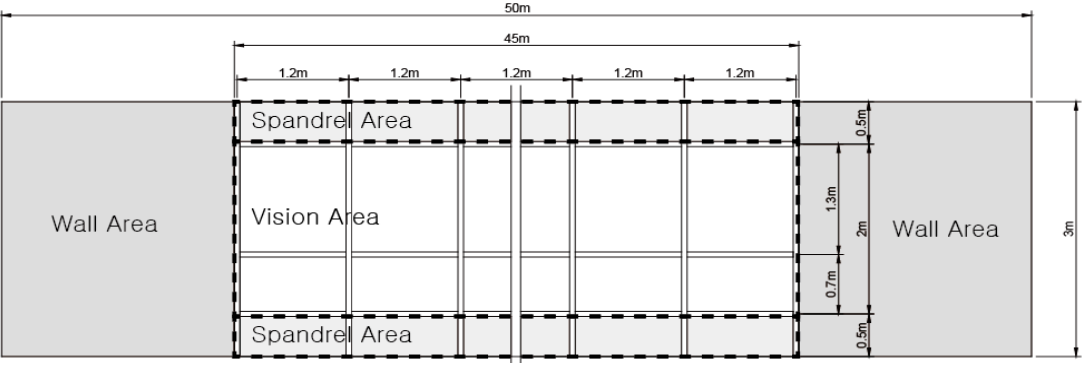
Figure 5. Analysis model plan ( left ) and EnergyPlus 8.5 simulation analysis model ( right ).